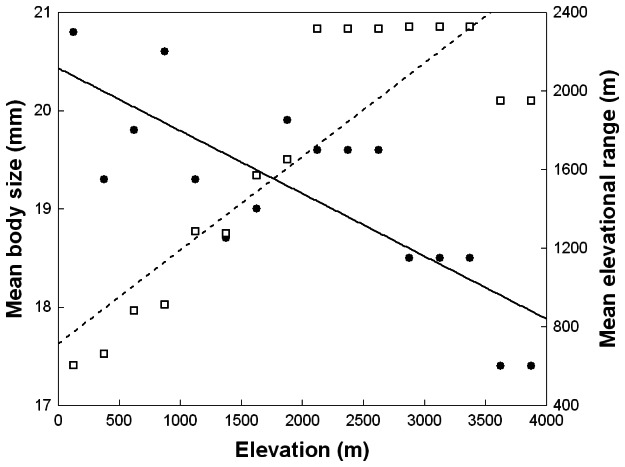
The relationship of mean body size (dots, solid line) and mean elevational range (squares, dashed line) of phanaeine dung beetle assemblages with elevation.Ordinary least squares regression: R
2 = 0.60, P<0.001 for mean body size; R
2 = 0.76, P<0.0001 for mean elevational range.